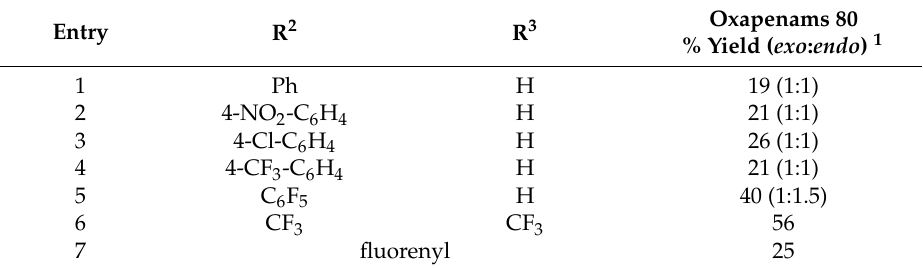
Table 10. Cycloaddition of azomethine ylide 79 to aldehydes 2 or ketones 3 (Scheme 18).